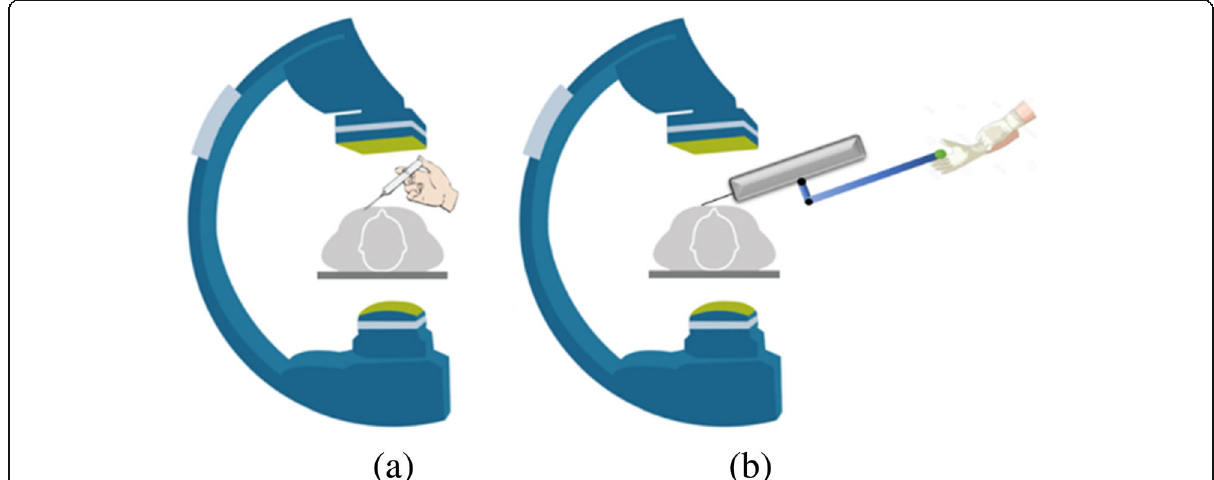
Fig. 3 Position of the hand with and without the device. On the left (a), without the device, the physician ’ s hand is directly exposed to radiation. On the right (b), with the device, the physician ’ s hand can stay away from the x-ray source